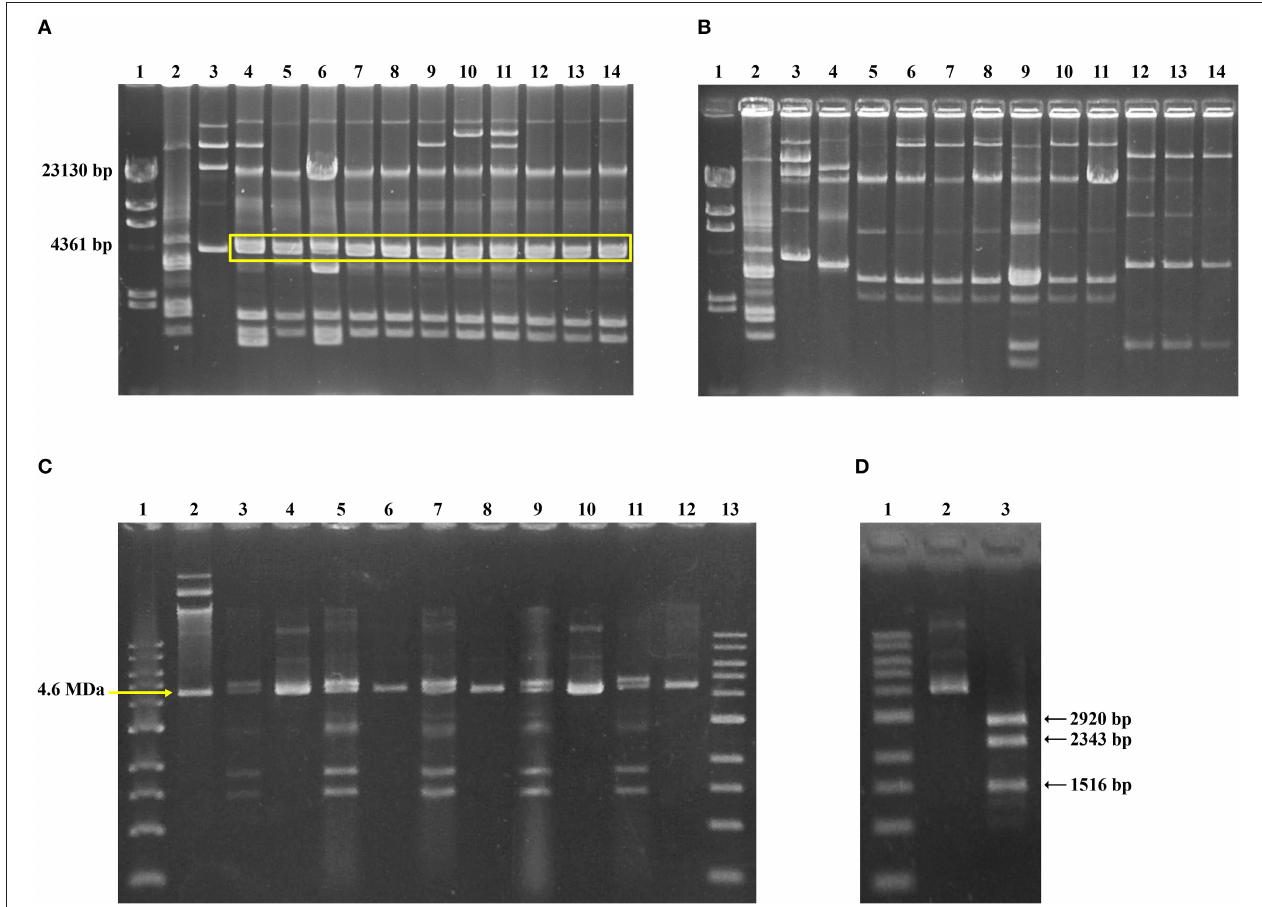
FIGURE 3 | Characterization of pABC-3 plasmid in Chilean TMP-resistant Shigella sonnei strains. Plasmid profiles of representative TMP R S. sonnei strains isolated during the outbreak ( A , lane 4 – 14) and before the outbreak ( B , lane 4 – 14), obtained by alkaline extraction and separation in 1% agarose gel electrophoresis. Molecular size markers in (A,B) : lane 1, Lambda Hin dIII DNA marker; lane 2, E. coli V517; lane 3, E. coli 39R861. A duplex band migrating near to 4.2 MDa is highlighted by a yellow line in panel A, which is absent in (B) . (C) Involvement of pABC-3 plasmid in TMP-resistance. Plasmid profiles from